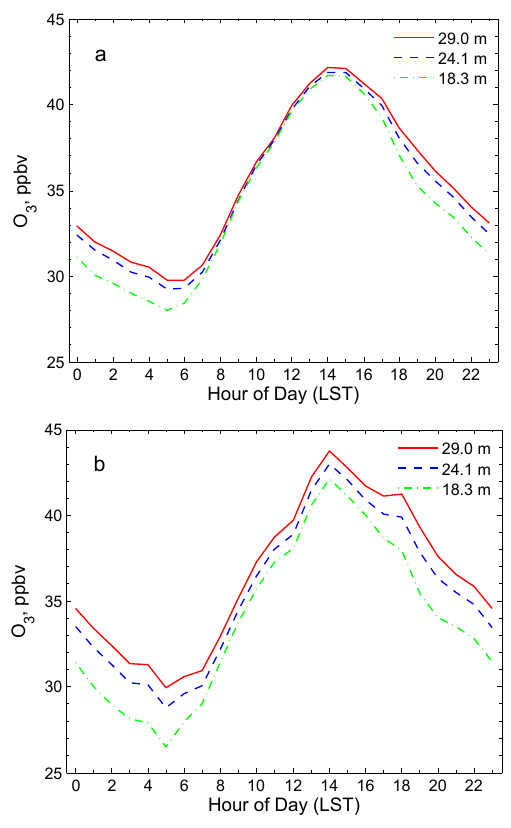
Figure 3. Mean diurnal cycles of O 3 concentration at heights of 29, 24.1, and 18.3m a.g.l. at Harvard Forest during 1993–2000. Panel (a) was derived from the original data and (b) was from the data after